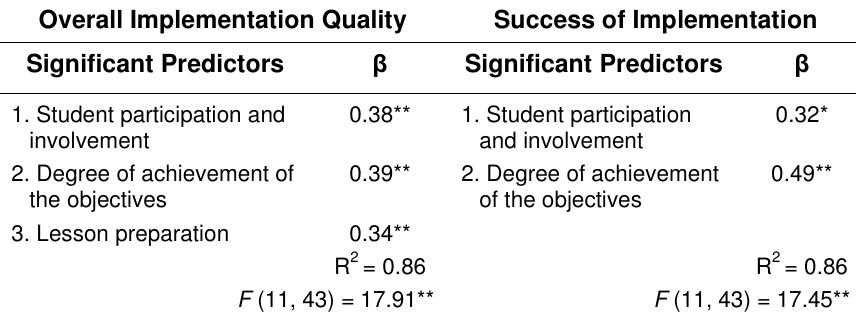
Summary of the Multiple Regression